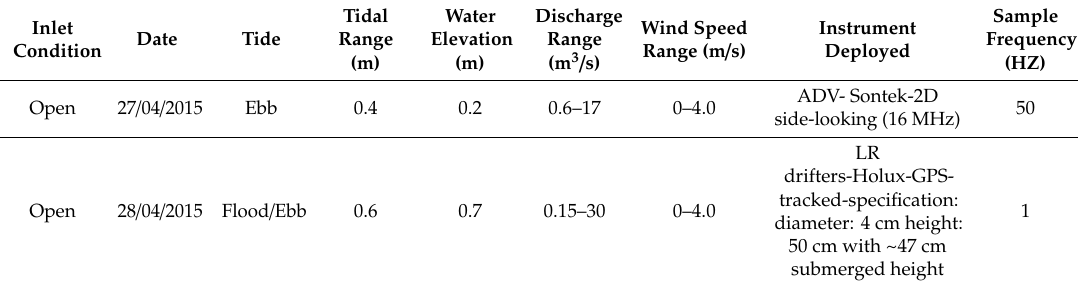
Table 1. Overview of the environmental conditions and instrumentation during the